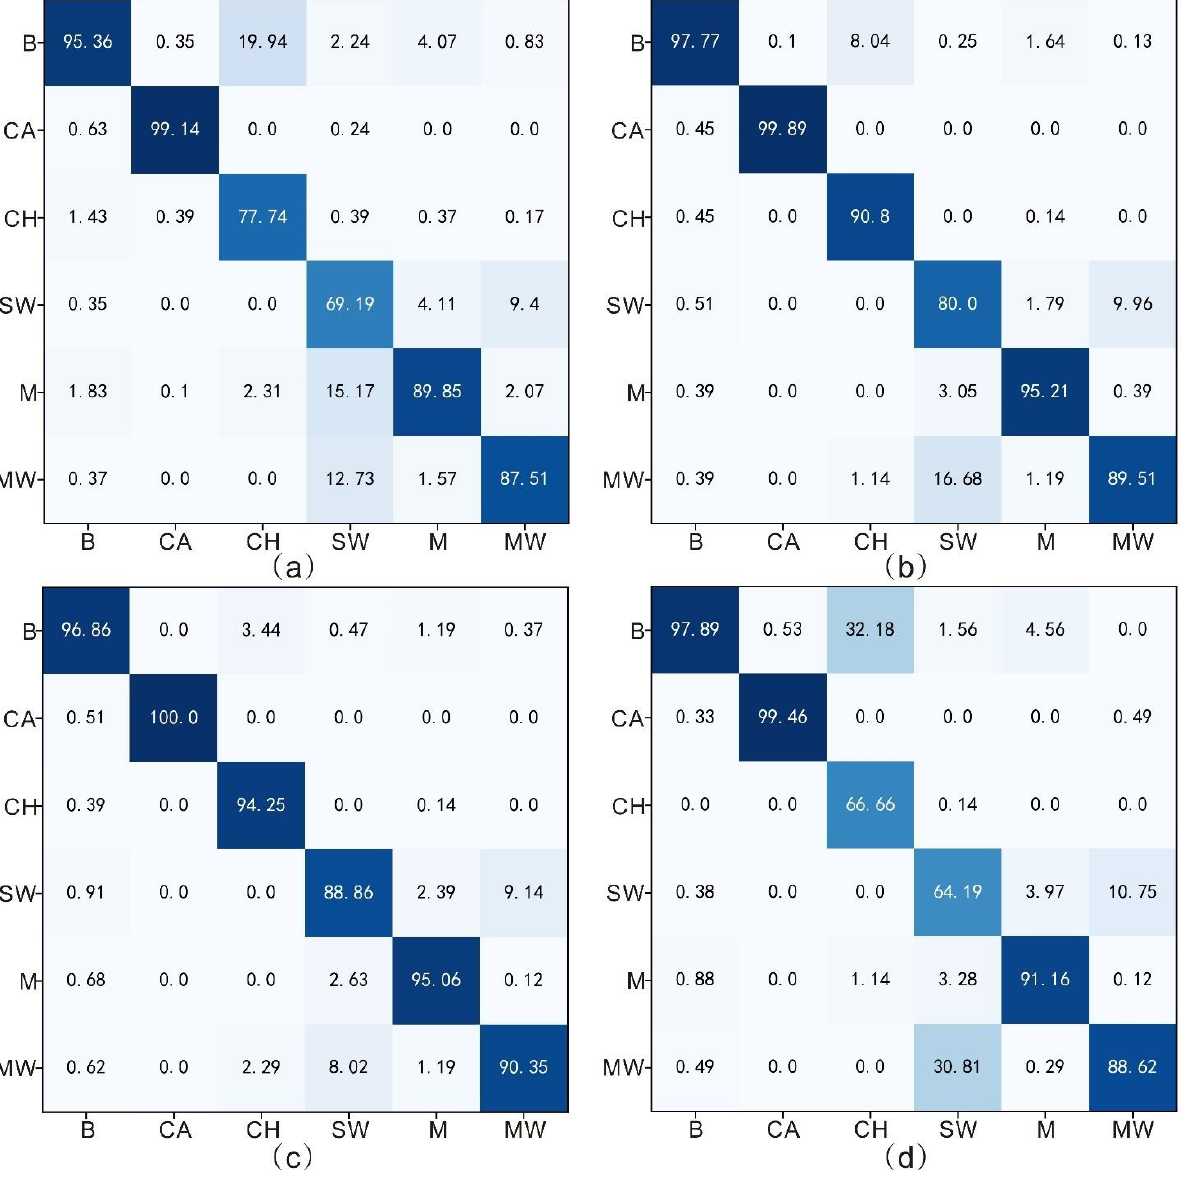
Figure 11. ( a ) The confusion matrix of the FCNN model for the test set. ( b ) The confusion matrix of the 1D CNN model for the test set. ( c ) The confusion matrix of the 1D and 2D CNN model for the test set. ( d ) The confusion matrix of the SVM method for the test set. CA represents calcite, CH represents chlorite, SW represents short-wavelength white mica, MW represents medium-wavelength white mica, M represents montmorillonite and B represents the